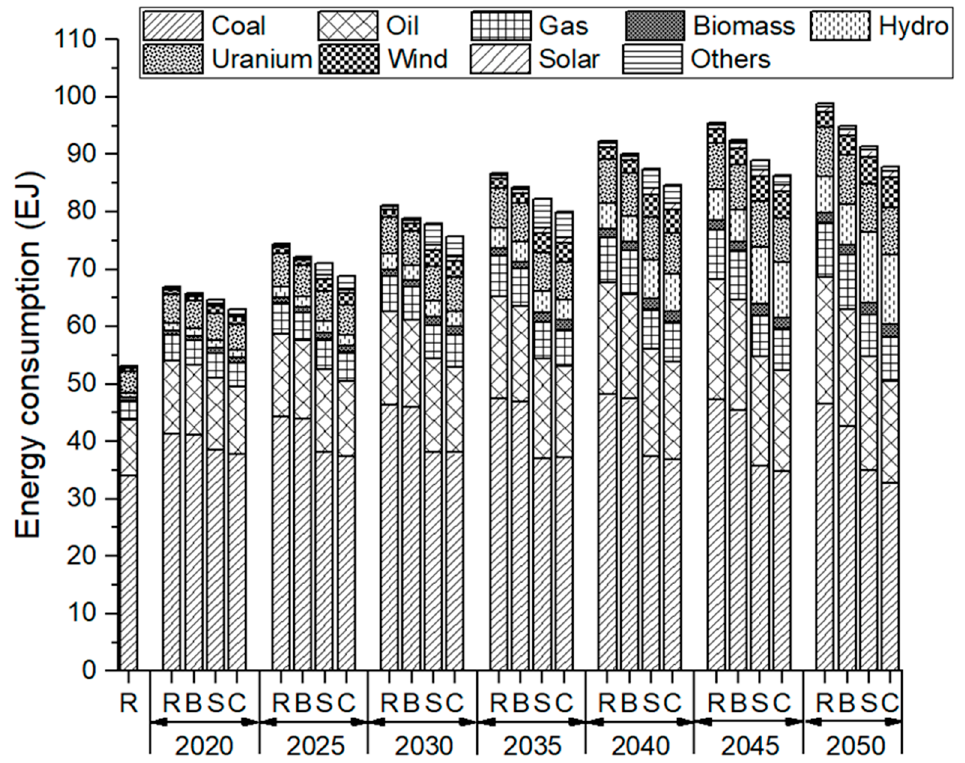
Figure 4. Primary energy consumption of the power industry.